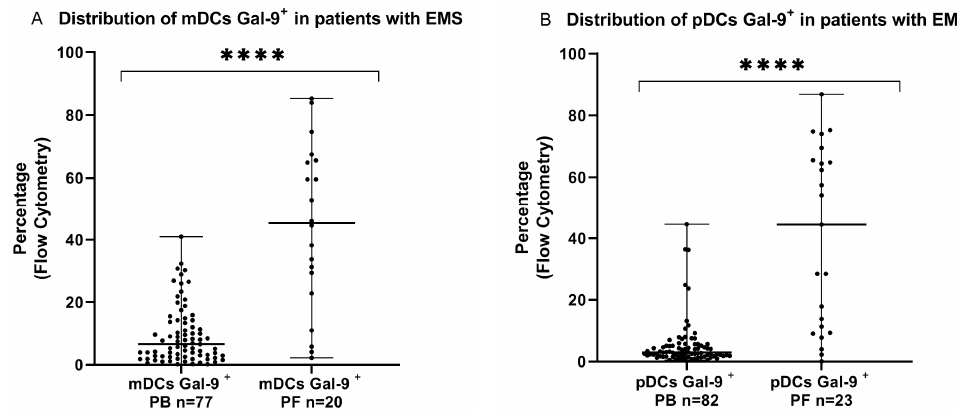
Figure 1. Percentage of mDCs ( A ) and pDCs ( B ) with Gal-9 expression in peripheral blood and peritoneal fluid in patients suffering from endometriosis. The median values with the following signs indicate statistically significant differences: **** p < 0.0001.